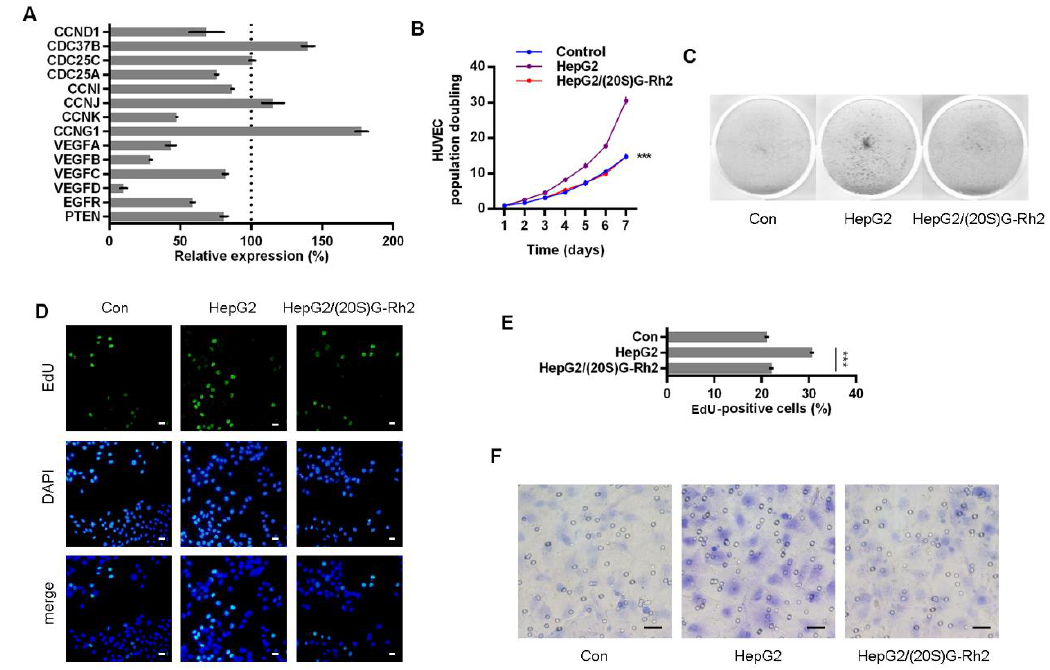
Figure 4. (20S)G-Rh2 inhibited HepG2 cells induced proliferation and migration of HUVECs. ( A ) Expression level of STAT3 target genes was determined in (20S)G-Rh2-treated HepG2 cells via qTR-PCR. ( B , C ) Colony formation of HUVECs were performed with cell-free supernatant from HepG2 cells pre-treated with (20S)G-Rh2 or not. The cell amount of each colony was shown as superimposed symbols with connecting lines ( B ), and the overall status of colony formation was shown as images after crystal violet staining ( C ). ( D , E ) EdU-labeling was utilized for new DNA synthesis detection in HUVECs co-cultured with HepG2 cells. EdU-positive cells were shown as florescent images ( D ), and EdU-positive ratio was shown as a histogram ( E ). ( F ) Migrated HUVECs co-cultured with HepG2 cells were shown as images after crystal violet staining. All experiments were performed with triple replicant. Significance analysis was shown as *** ( p < 0.001). Scale bar presented 20 μm.